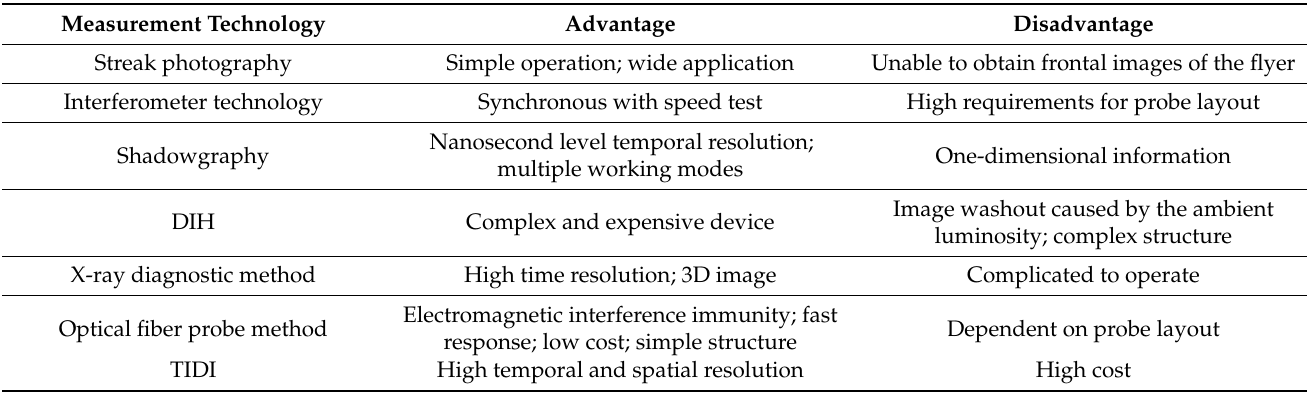
Table 4. Comparison of different flyer morphology investigation